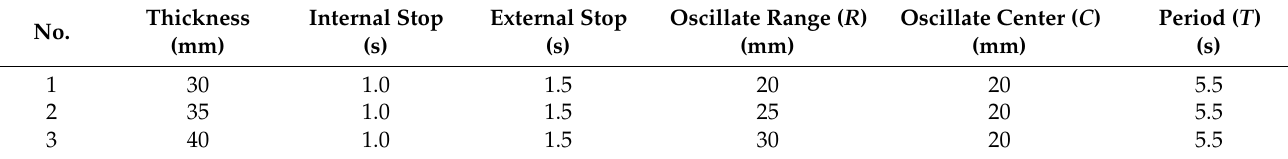
Table 6. Oscillate-stop parameters of welding heat